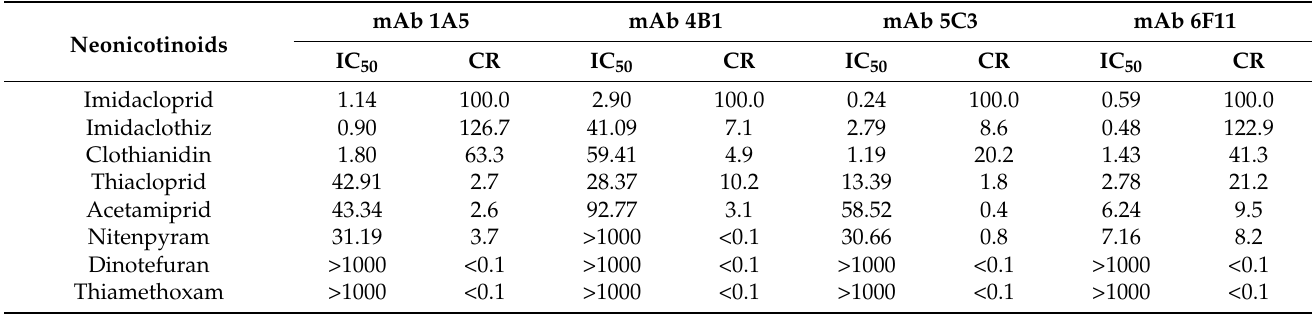
Table 1. Sensitivity (IC 50 , ng/mL) and CR (%) of four mAbs toward 8 neonicotinoid